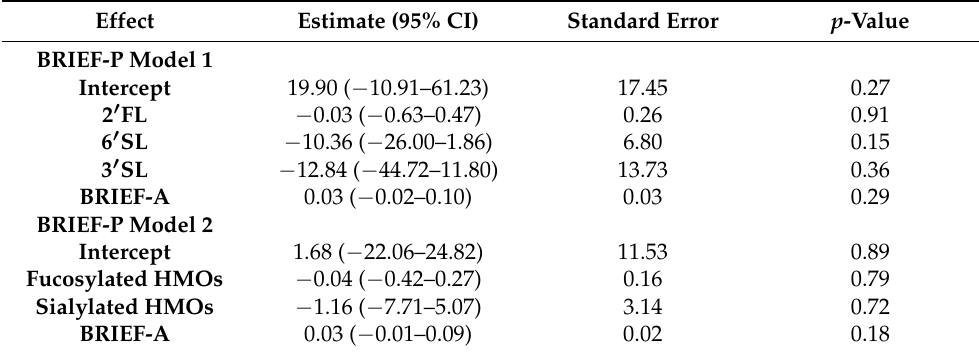
Table 8. Multiple logistic regression results of the relation between the HMOs and HMO groups and the BRIEF-P (exclusively breastfed